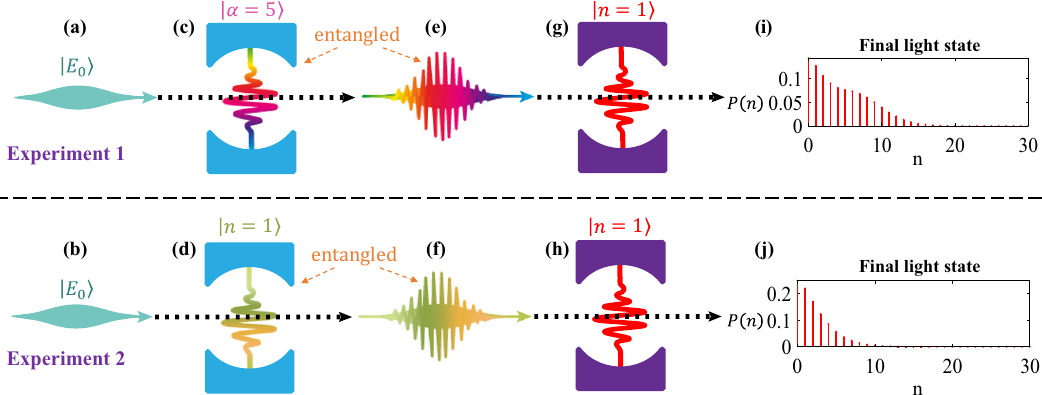
Fig. 3 The electron transfers quantum information between photonic cavities. The schemes show two experiments with identical parameters, except for the fi rst cavity ’ s initial light state. The fi rst interaction creates a joint entangled state of the electron and the cavity state. The second interaction transfers information to the second cavity. The fi rst interaction can be understood as shaping of the electron wavefunction 49 that can then alter the statistics of the second cavity. a, b The same initial (unshaped) electron interacts with two cavities. Each scheme presents a different light state in the fi rst cavity. The initial light statistic in the fi rst cavity: a coherent state with α = 5 ( c ) or a Fock state with one photon ( d ). e, f The electron is shaped by the light state in the fi rst cavity. g, h The light statistic in the second cavity for both experiments is a Fock state with one photon. It is modi fi ed in a way that depends on the state of light in the fi rst cavity. i, j The fi nal light statistics in the second cavity, plotted after 20 consecutive electron interactions, showing a clear difference that arises from the difference in light statistics in the fi rst cavity. The interaction strength is g Q =